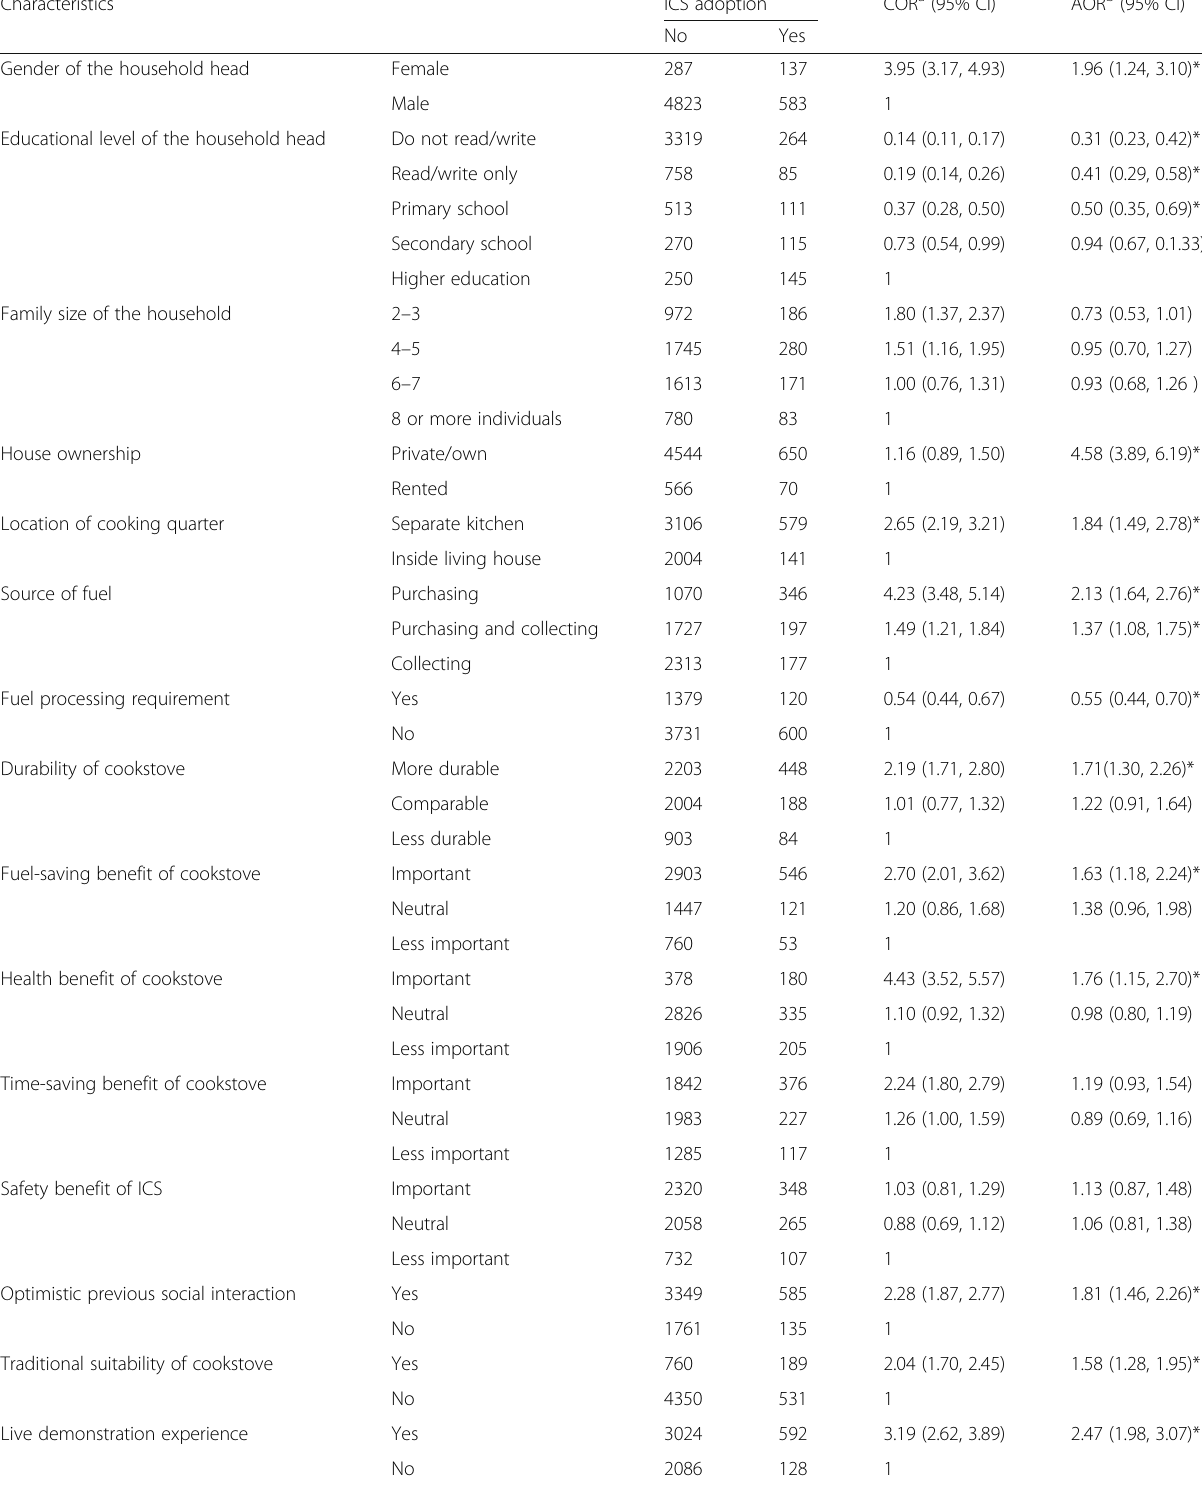
Table 3 Logistic regression analyses describing the associations between ICS adoption and possible predictor variables in Northwest Ethiopia, May 2018 ( n =